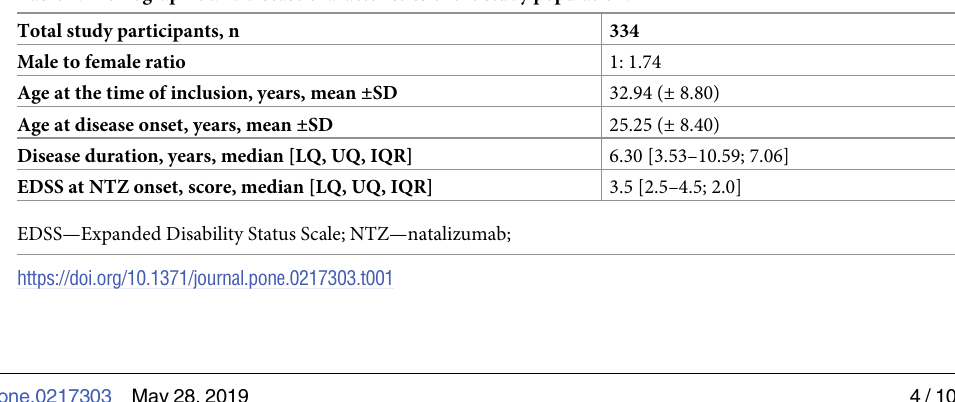
Table 1. Demographic and disease characteristics of the study